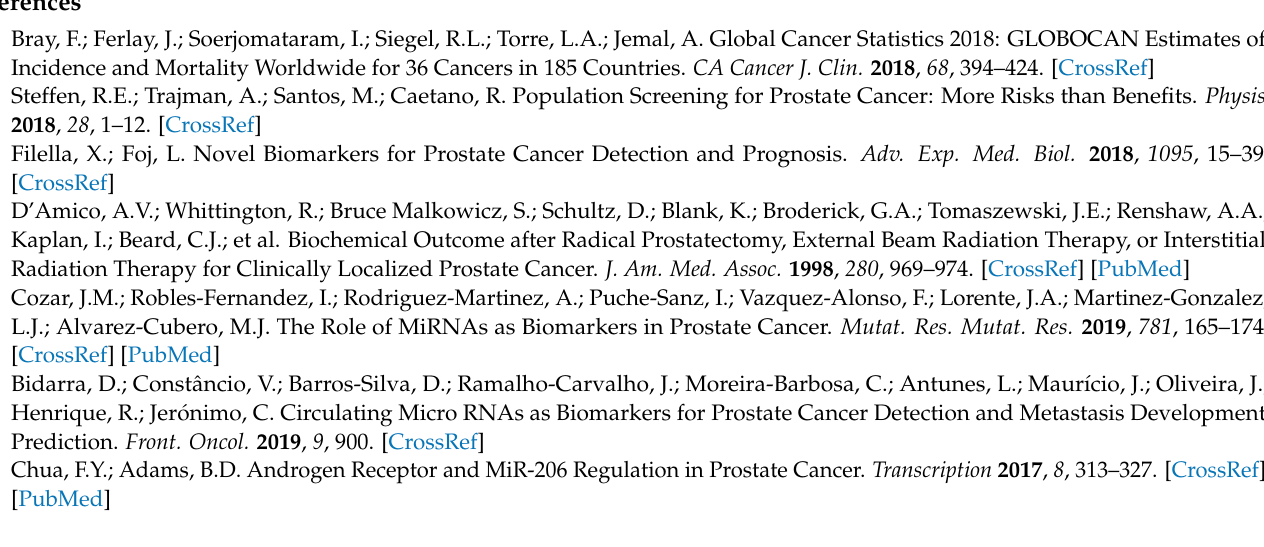
Table S2: Comparative prostatic expression of miRs (27a-3p; 124; 130a; 488-3p; 506) and AR molecular markers between the CaP and NPH groups. Table S3: Comparisons of Western blot expression values of investigated miRs. Table S4: Sensitivity and specificity results for each coordinate point of the ROC curve for miRNA that tested positive if less than or equal to the cutoff point (miR124, miR130a, miR488-3p, miR506). Table S5: Sensitivity and specificity results for each coordinate point of the ROC curve for miRNA that tested positive if greater than or equal to the cutoff point (miR27a-3p). Figure S1: Western